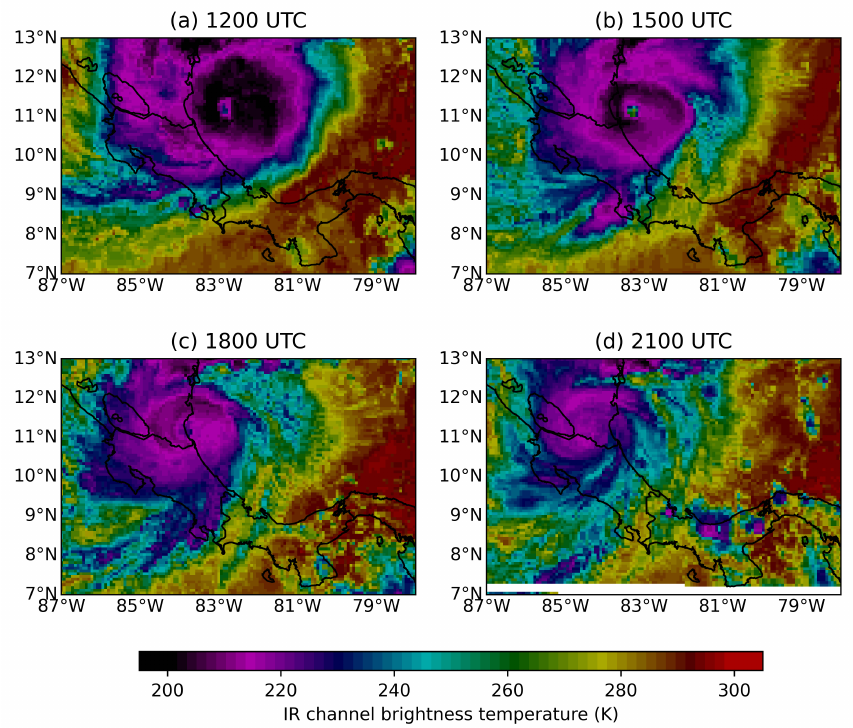
Figure 2. Infrared GOES-13 satellite imagery of tropical cyclone Otto at ( a ) 1200 UTC, ( b ) 1500 UTC, ( c ) 1800 UTC and ( d ) 2100 UTC 24 November 2016. (Data source: HURSAT, Knapp and Kossin